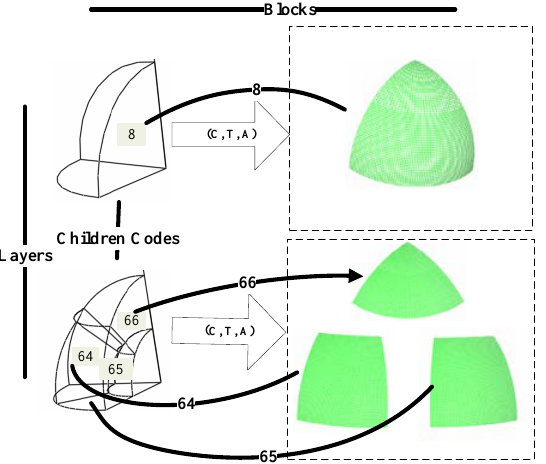
Figure 3. Hierarchical blocked multi-resolution data storage